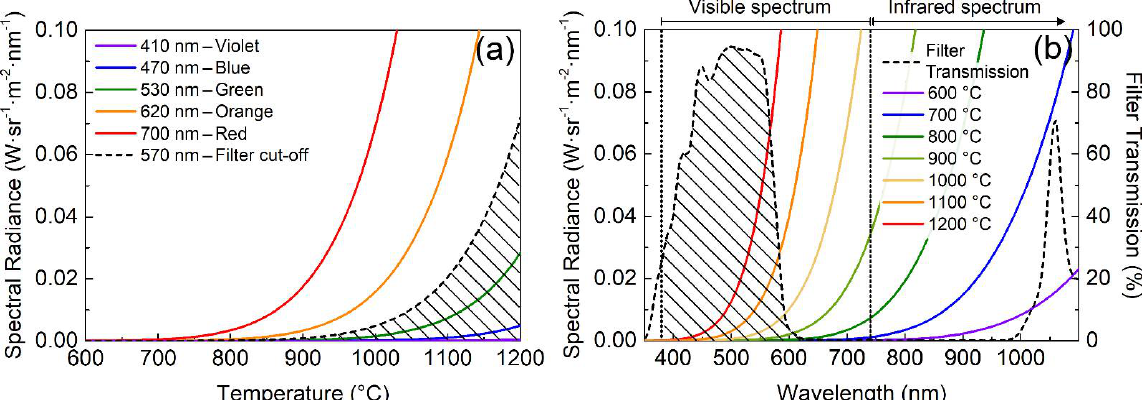
Figure 3. ( a ) Spectral radiance as a function of temperature for different wavelengths. The hatched area under the dashed line shows the radiation that passes through the shortpass filter and ( b ) the spectral radiance (solid lines) and the blue-green shortpass filter transmission (dashed line) as a function of wavelength for different temperatures. The hatched area under the dashed line shows the wavelength range in the visible spectrum, which passes through the filter.